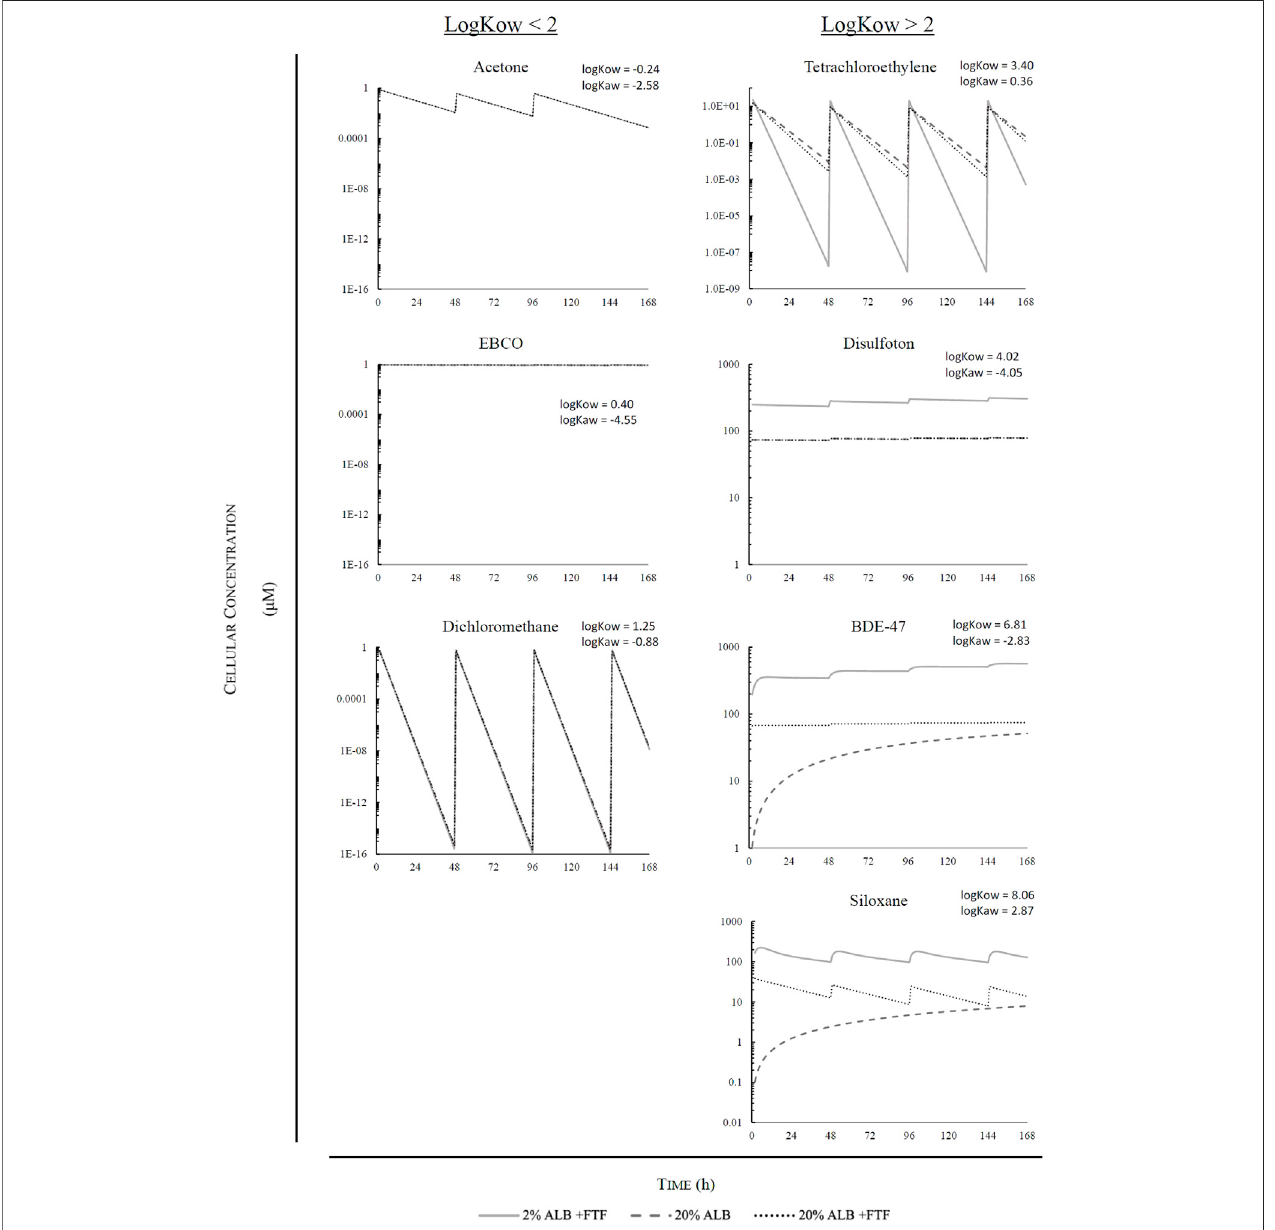
FIGURE5| Graphic illustrations ofsimulations for chemicals withlogK OW < 2:Acetone,EBCO, and Dichloromethane; and illustrations ofsimulationsforchemicals with logK OW > 2: Tetrachloroethylene, Disulfoton, BDE-47, and Siloxane D5.